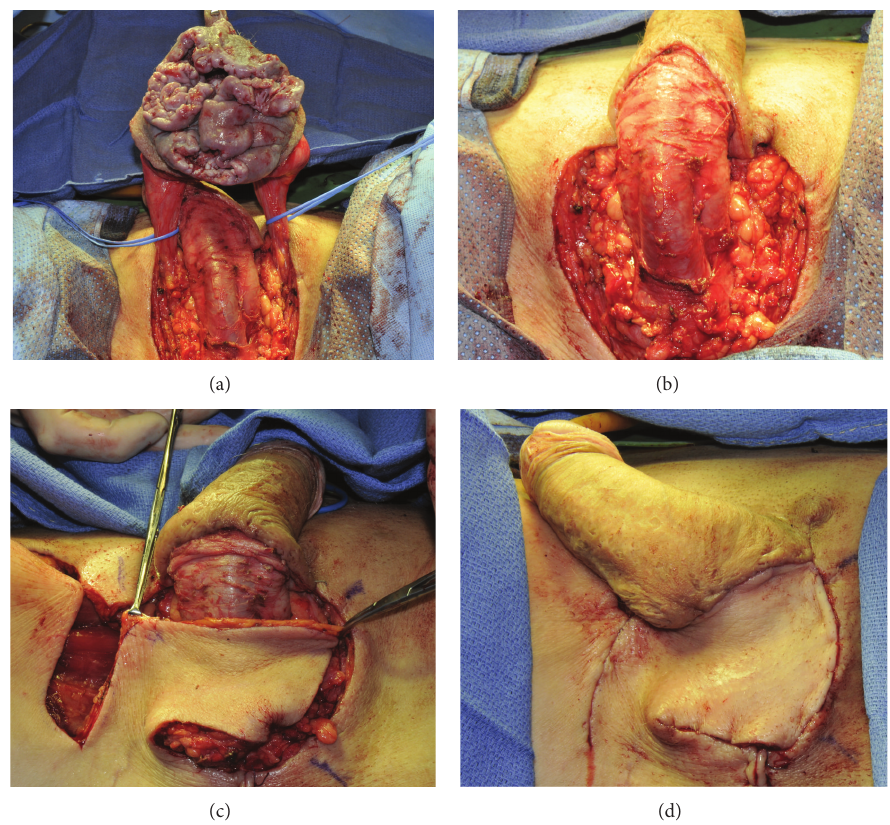
Figure 3: (a) Wide local excision of lesion and isolation of spermatic cords. (b) Completion of radical scrotectomy and bilateral simple orchiectomy. (c) Pudendal thigh flap mobilized superiorly for closure. (d) Completion of reconstruction with pudendal thigh flap.